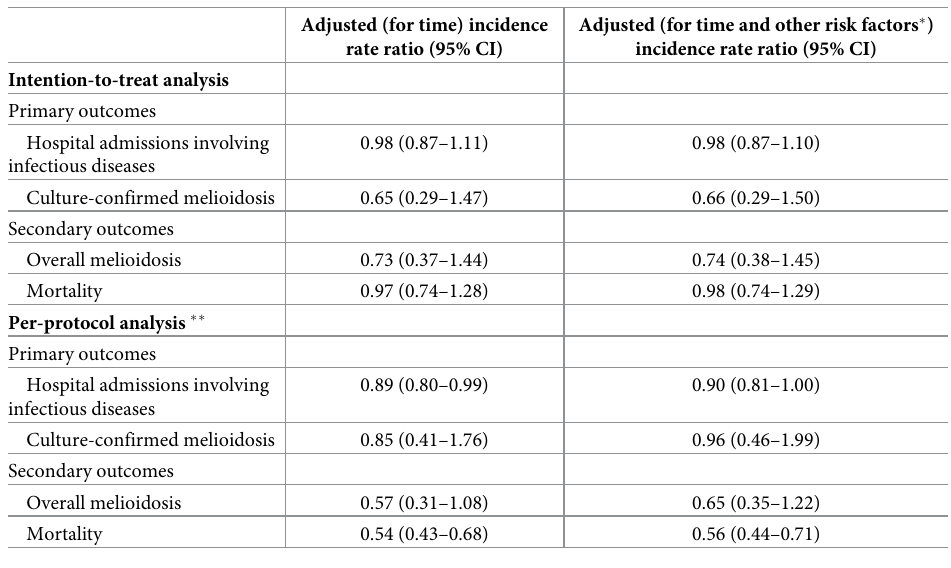
Table 3. Outcomes of the